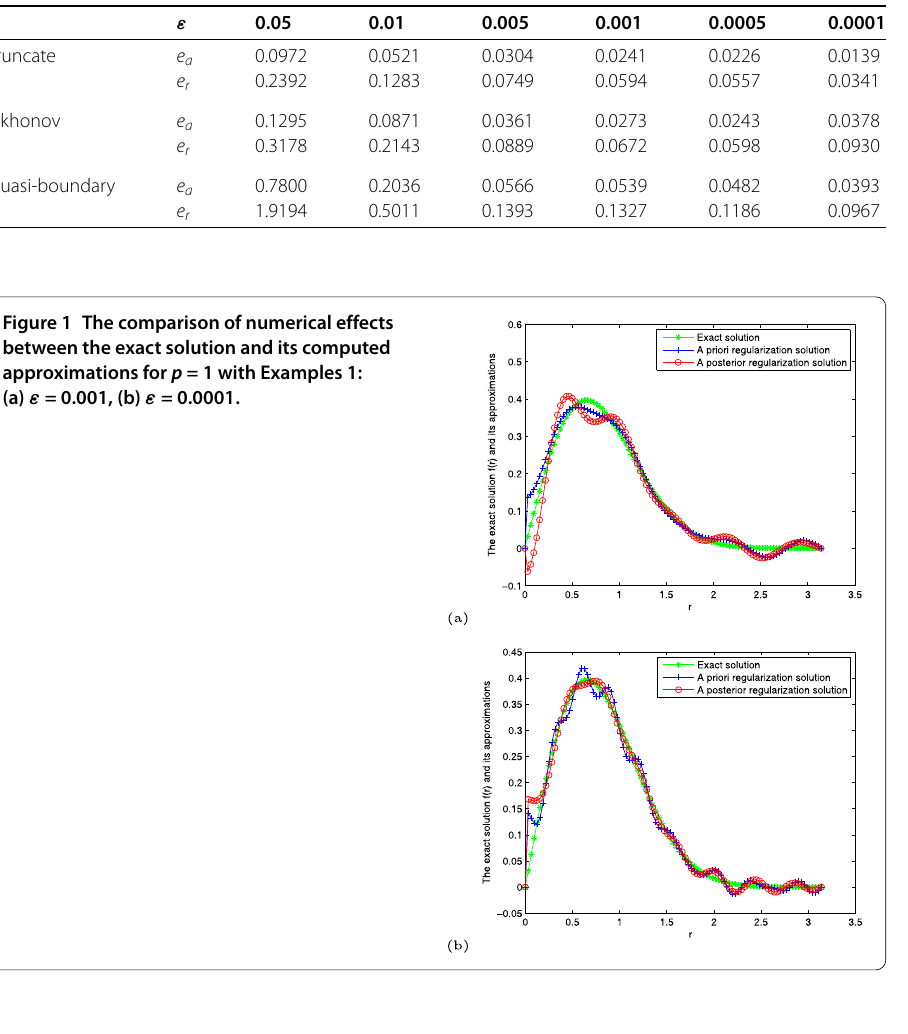
Figure indicates the comparisons between the exact solution and its computed approximation with different noise levels for Examples . From Figures -, we can find that the smaller ε , the better the computed approximation is. Moreover, we can also see that the a posteriori parameter choice also works